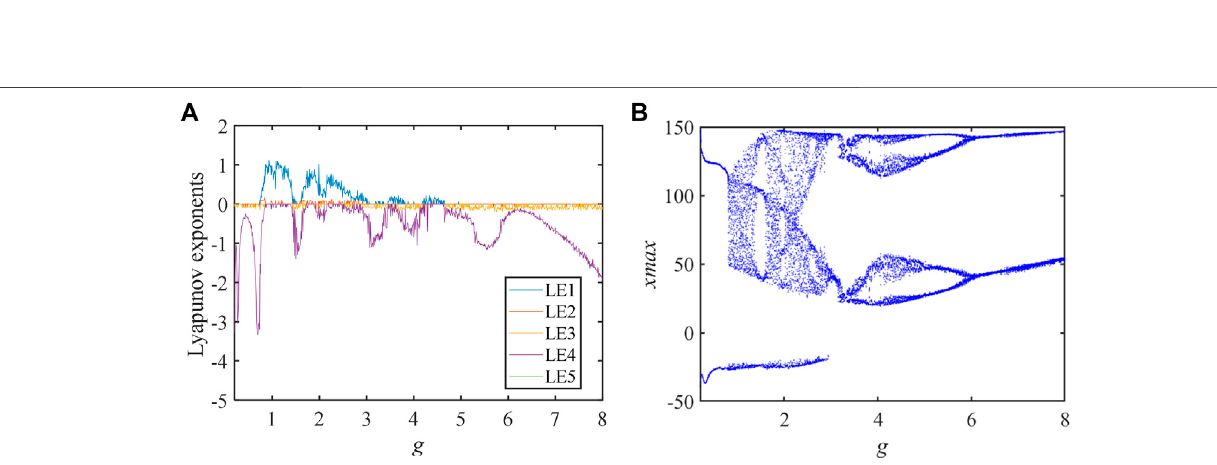
Frontiers in Physics |